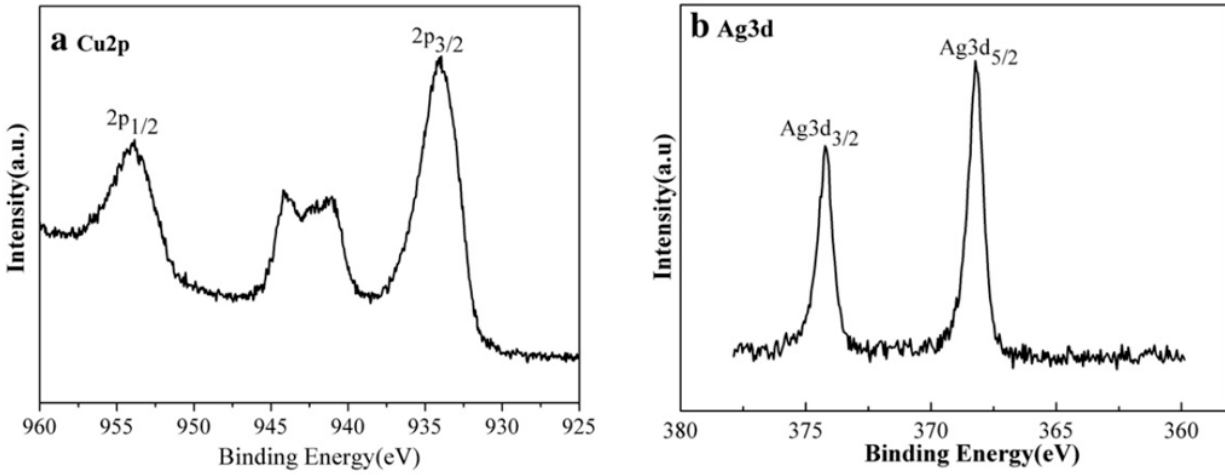
Figure 15. XPS spectra of ( a ) Cu2p and ( b ) Ag3d in AgCu 2 O nanoalloys. Reproduced with permission from Reference [242]. Copyright 2015, Elsevier.